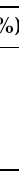
Table 1. Dice similarity coefficient (DSC) obtained through the automatic detection of HNTs for each considered concentration level.